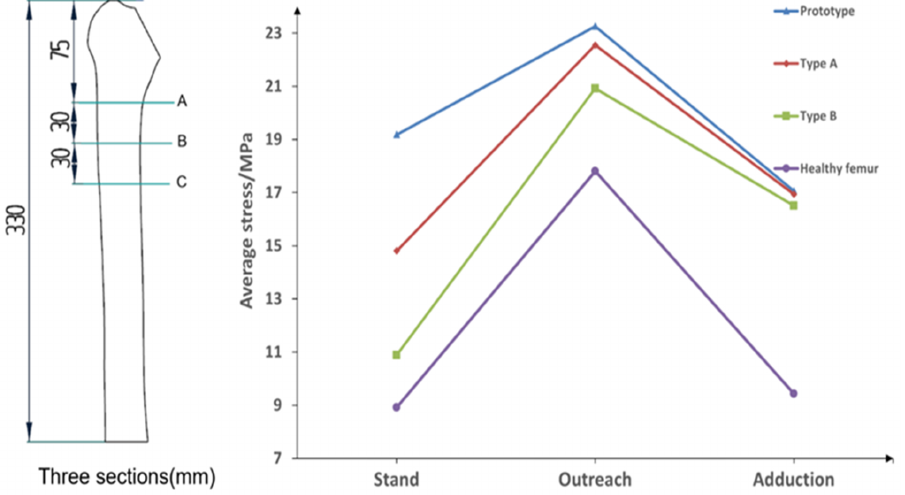
Figure 10. Average stress on the femur under different types of femoral stem under three